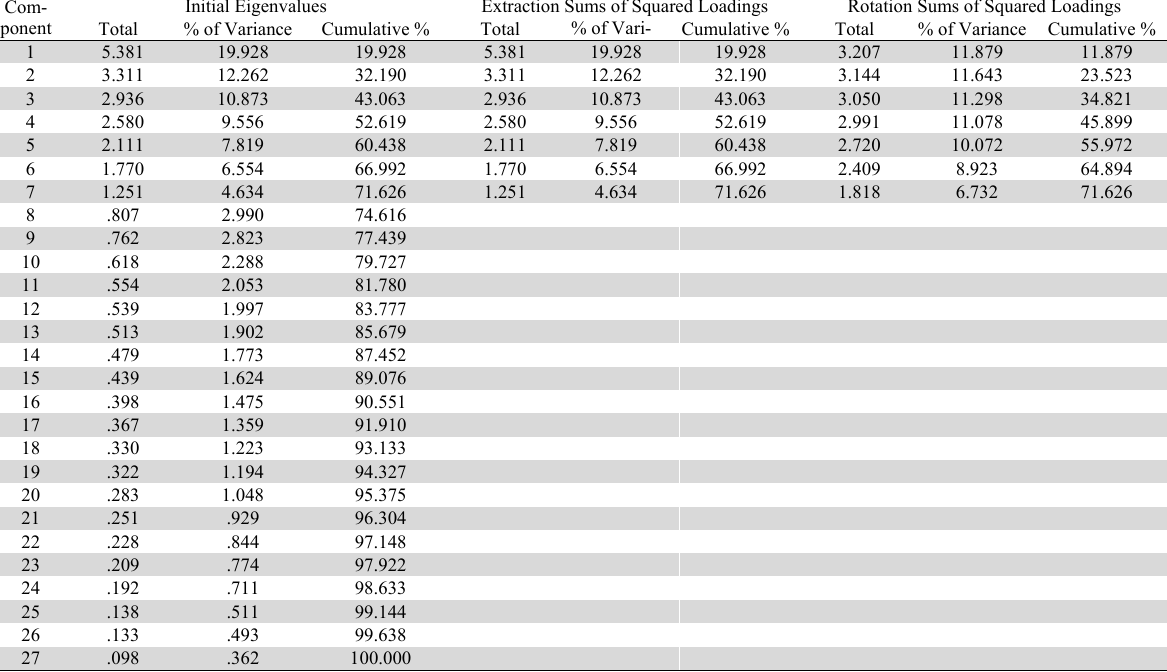
Examine the degree of interpretation of the observed variables for the factor influencing the student's decision to buy a skin care product for a female student in Da Nang City Extraction Sums of Squared